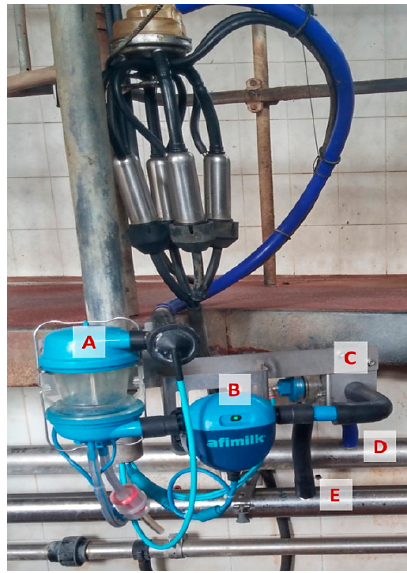
Figure 1. The Afilab (B), installed next to the AfiMilk (A) milkmeter at each milking unit, performs real-time analysis of milk components using spectroscopy in the near infrared. Milk with predefined coagulation properties is separated and conveyed, thanks to controlled valves (C), through two different milklines (D or E) in a predetermined cooling tank.